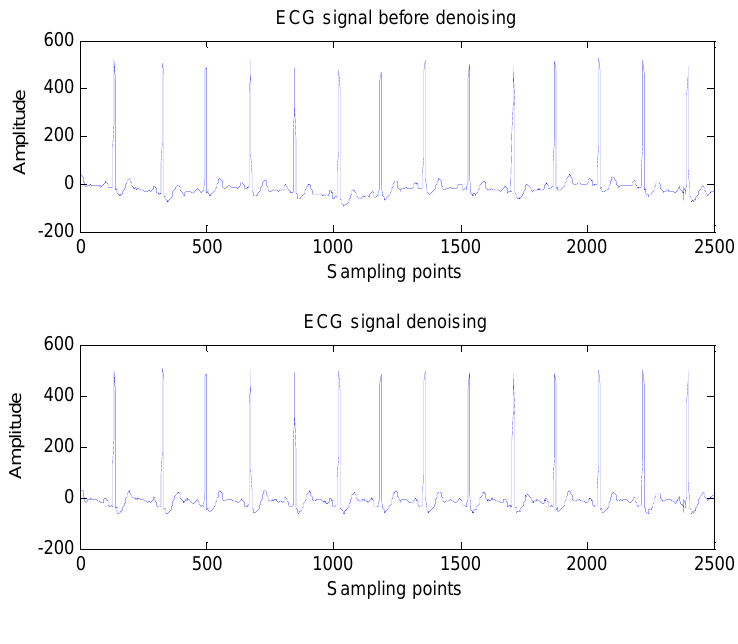
Figure 8. Comparison of ECG signal before and after denoising (ECG record s20051m selected from ST long